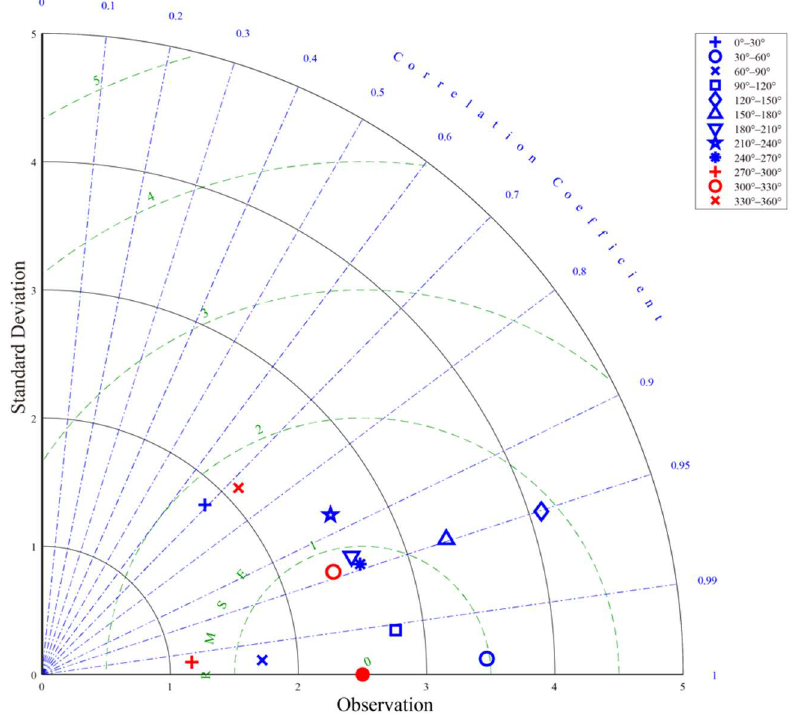
Figure 11. Taylor diagram of SAR-derived wind speeds versus SFMR observations.